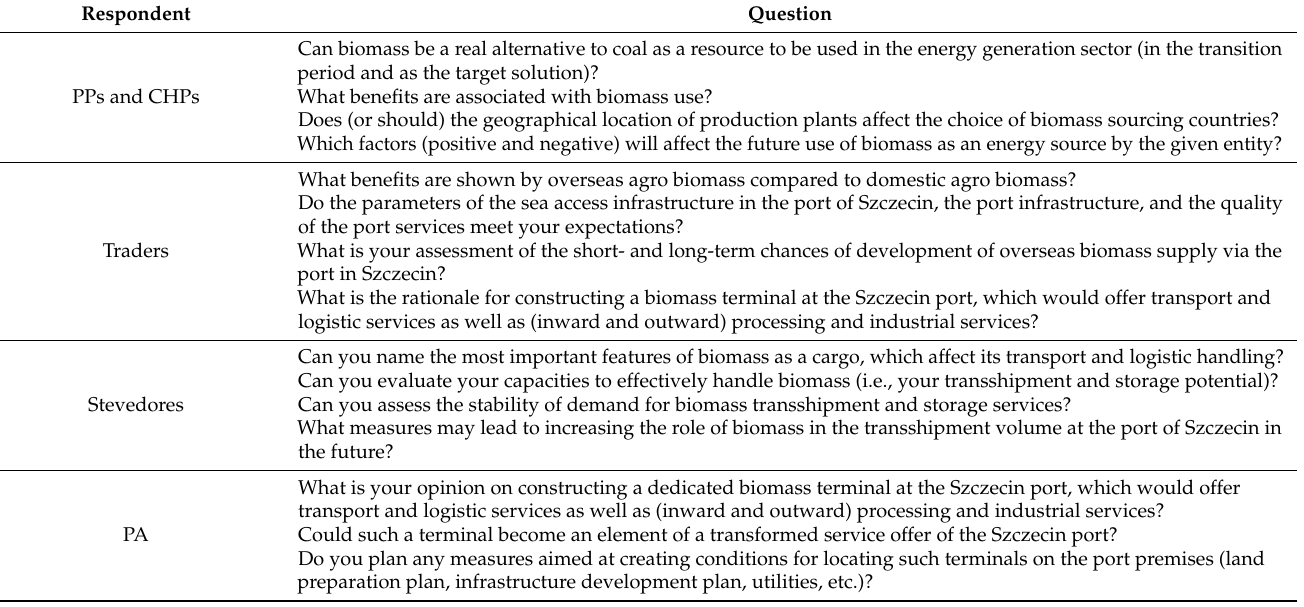
Table 2. Questions addressed to the responders during the semi-structured in-depth